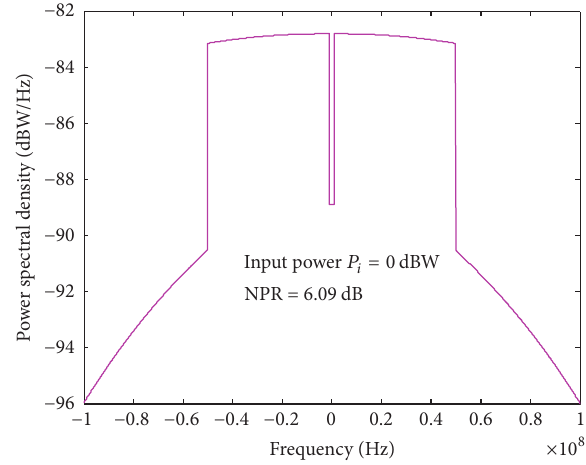
Figure 5: Plot of the Chebyshev transform 𝑔(𝐴) .